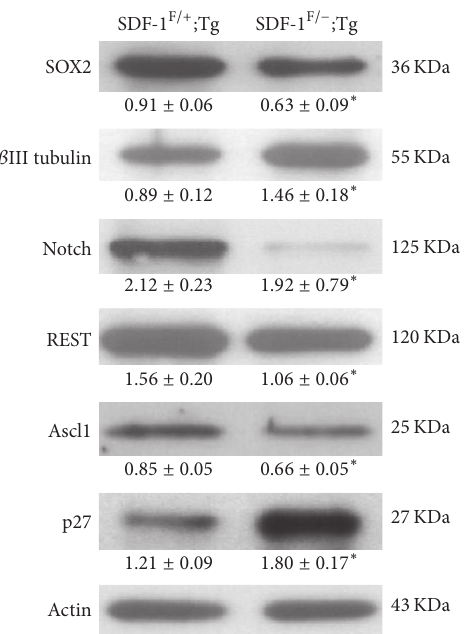
Figure 6: Loss of SDF-1/CXCR4 signaling pathway promotes neural fate commitment via activation of neural lineage genes. Whole cell lysates were prepared from SDF- 1 F /+ ;Tg or SDF- 1 F /− ;Tg group after 4-OHT treatment. Western blot analysis was conducted using anti- SOX2, 𝛽 III tubulin, Notch, REST, Ascl1, and p27 antibodies. The numbers under each blot are intensity of the blot relative to that of internal control. Results are representative of three independent experiments with neurospheres from three independent litters. Data represent the mean ± SEM, ∗ 𝑝 < 0.05 , Student’s 𝑡